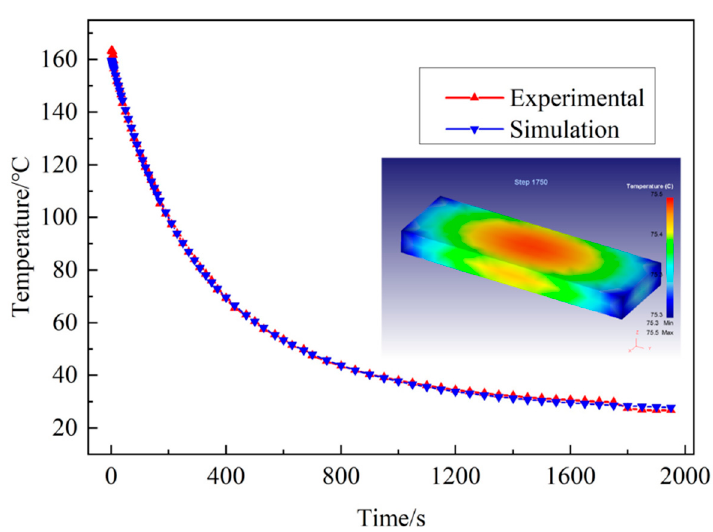
Figure 11. Comparison between the simulation and experiment of the temperature drop process during air cooling.